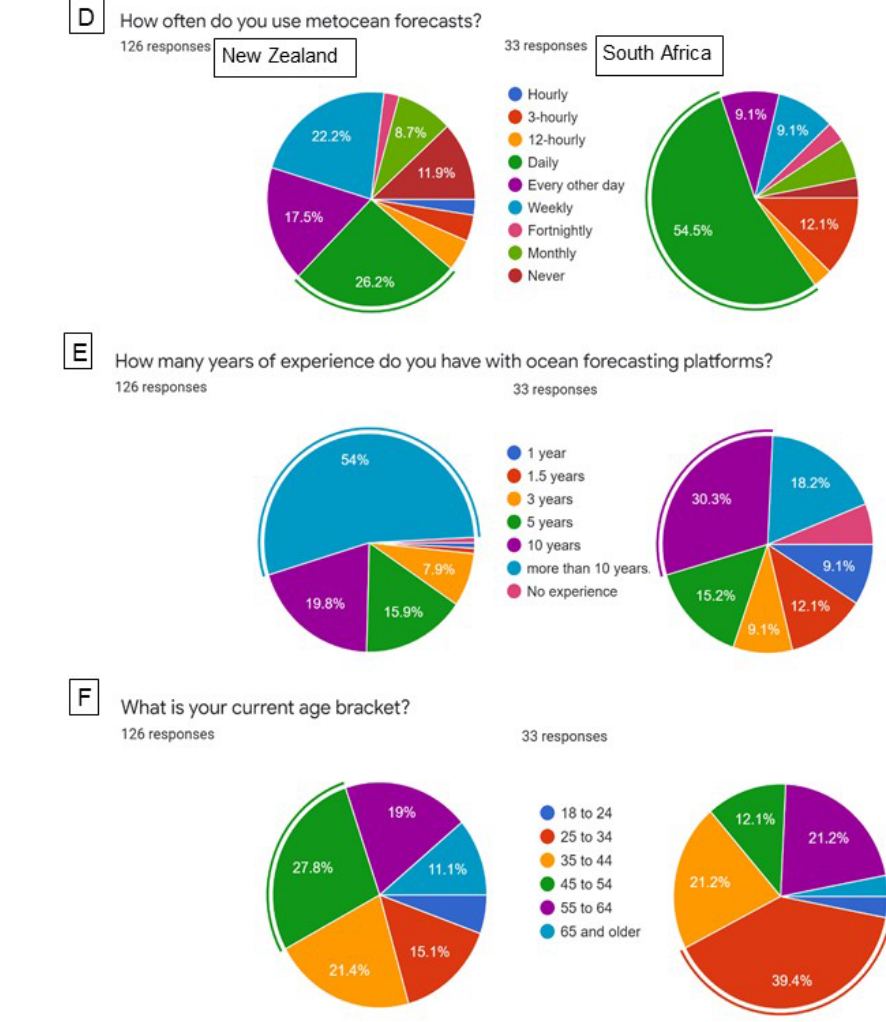
Figure 1. Summary of demographic questions related to the present study. Here questions D to F are given with questions A to C given in Appendix A, together with their